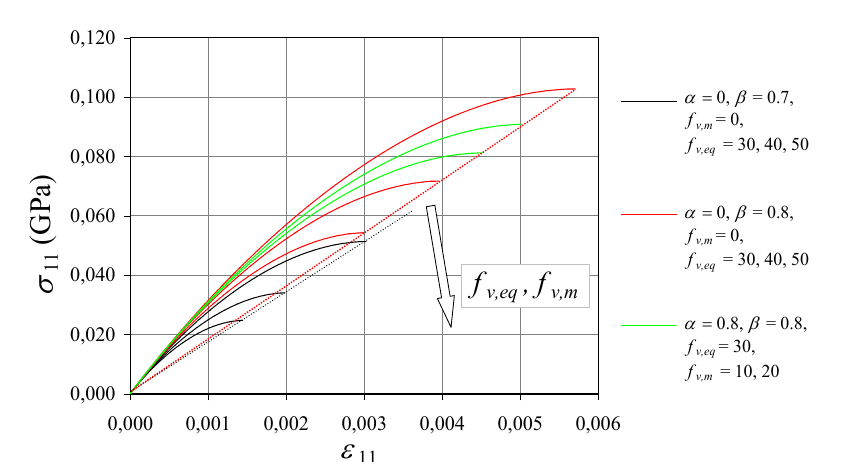
Figure 1: Stress-strain curves of concrete in uni-axial